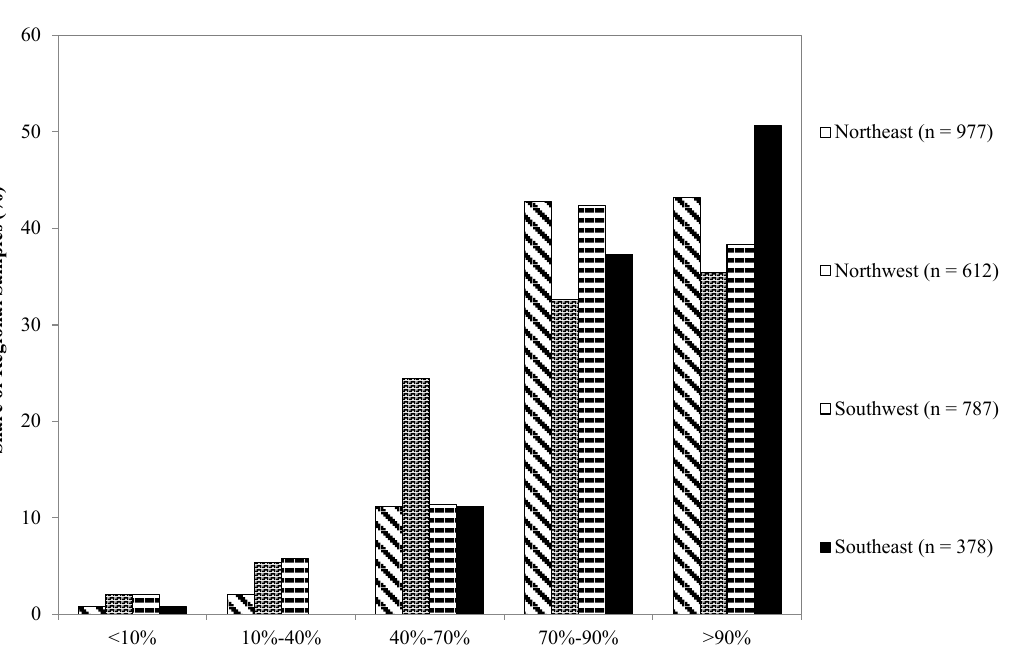
Figure 1. Regional distribution of survival rates of household conversion of cropland to forests program planted